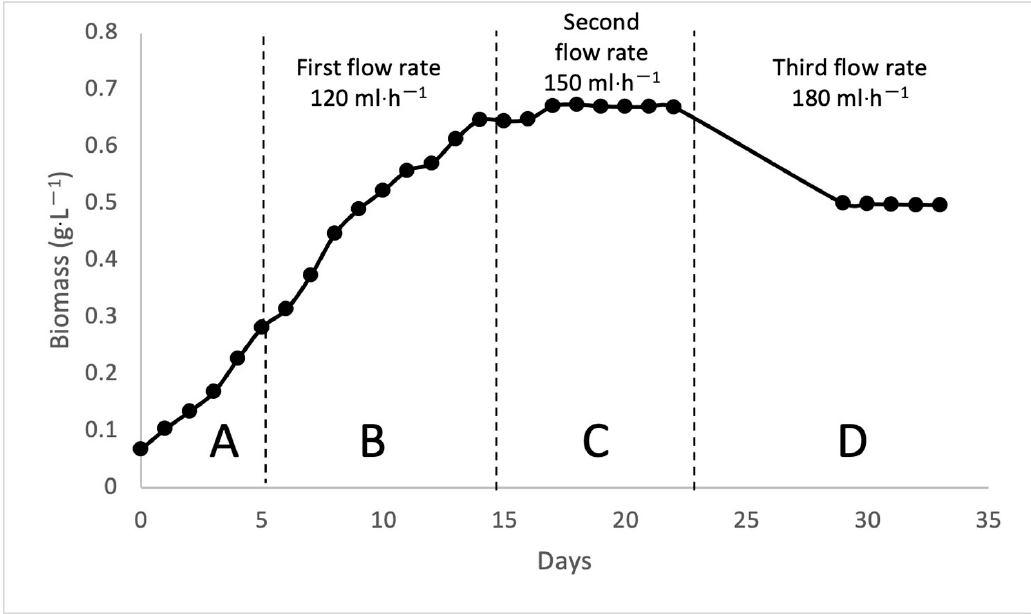
Figure 3. The growth of cell biomass for different pH via continuous bioreactor.